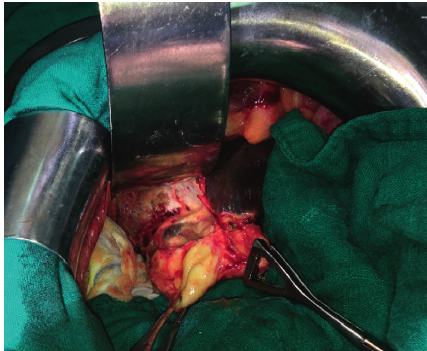
Figure 3: Operative image showing a fistulous communication between a liver hydatid cyst and the gallbladder.